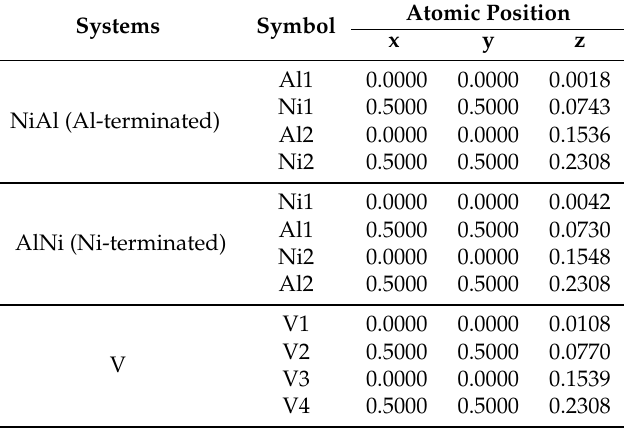
Table 2. The relaxed atomic arrangements of 7-layer NiAl, AlNi and V for surface energy calculations. We only show the atomic arrangements of the top four layers due to the symmetry of the supercell.